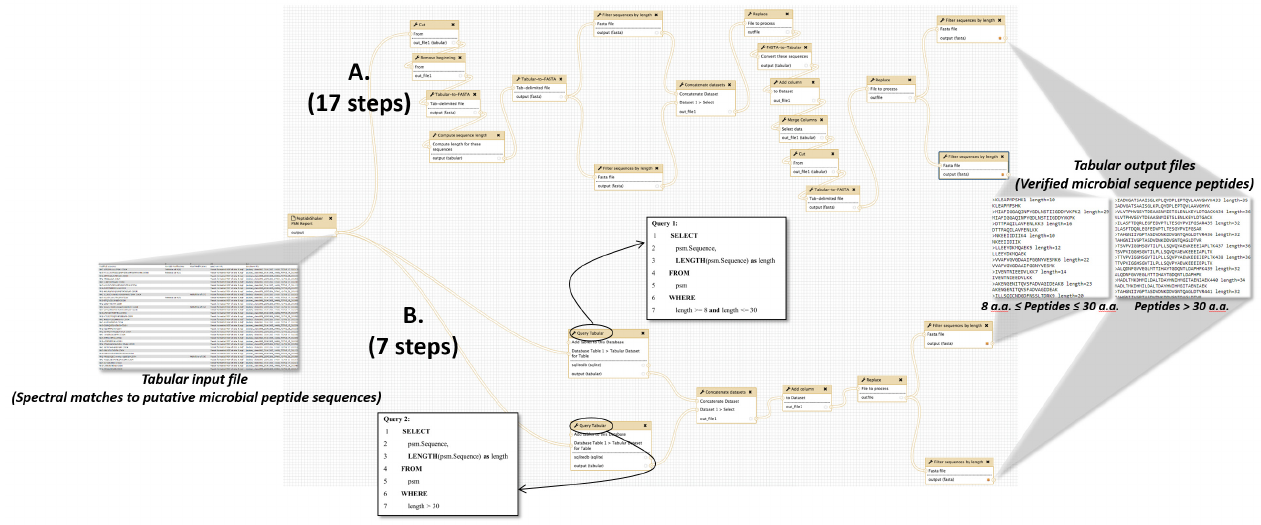
Figure 3. A metaproteomics workflow using Query Tabular. This workflow verifies the presence of detected microbial peptides by matching peptides against the NCBI nr protein sequence database using the BLASTP tool. ( A ) Using conventional Galaxy text manipulation tools, the workflow requires 17 steps to achieve desired outputs. ( B ) When utilizing Query Tabular, desired results are obtained in seven steps. The figure also displays the structure of the tabular input file containing peptide sequences putatively from microbes in the sample, and the tabular output file which contains verified microbial peptide sequences. One output contains peptides between 8 and 30 amino acids (a.a.) in length, while the other contains peptides 30 a.a. or greater in length, due to BLASTP requiring separate analysis based on length of peptide sequences. The two inset boxes show the two SQL queries used in this workflow, made possible by Query